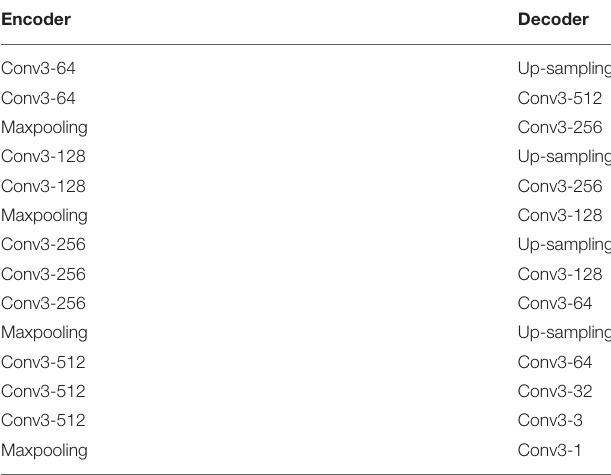
TABLE 1 | The basic configuration of the segmentation